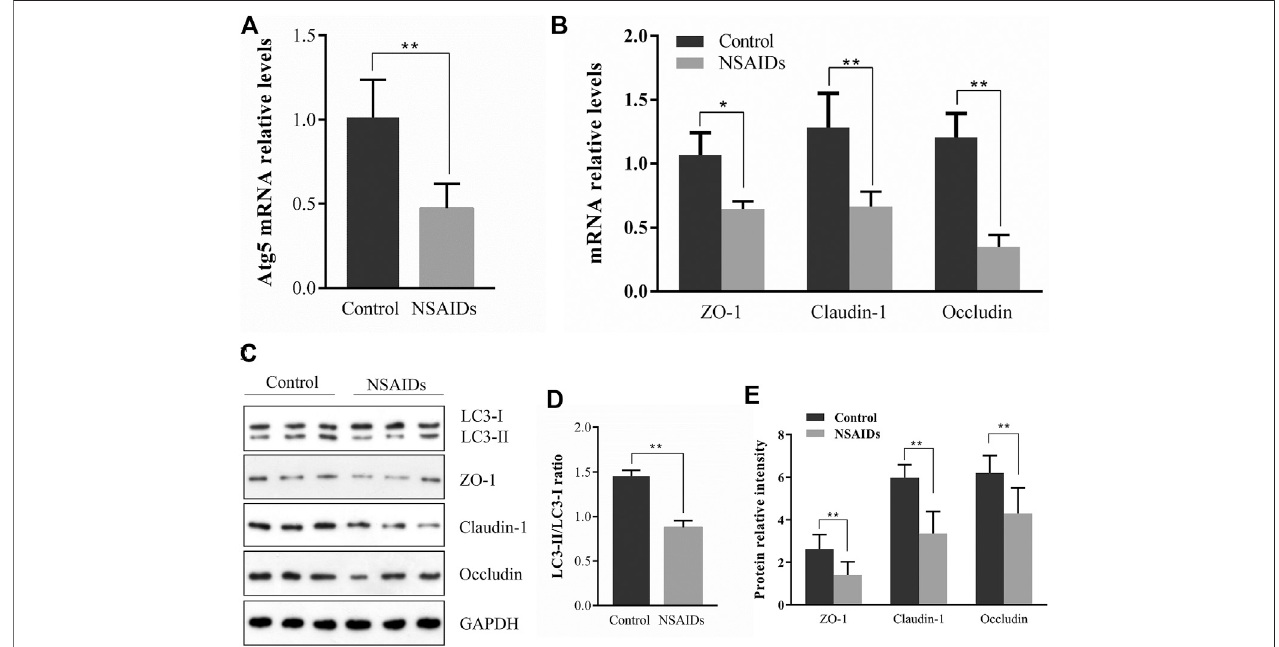
FIGURE 2 | Relationship between autophagy and tight junction (TJ) barrier in nonsteroidal anti-in fl ammatory drug (NSAID)-induced small intestine injury. Levels of mRNA were determined in the NSAID model group and control group using quantitative reverse transcription-polymerase chain reaction (qRT-PCR) for (A) autophagy- related 5 (Atg5) and (B) zonula occludens (ZO-1), claudin (CLDN)-1, and occludin (OCLN) (C) Glyceraldehyde 3-phosphate dehydrogenase (GAPDH) was used as a loadingcontrol( D,E) Western blottingwasused toanalyze protein levels intheNSAIDmodel groupand control group (D) Proteinlevels oflightchain3(LC3)forms LC3-II and LC3-I were determined using ImageJ software and the signal density ratios of LC3-II/LC3-I were calculated (E) Protein levels of ZO-1, CLDN-1, and OCLN. ** p < 0.01.